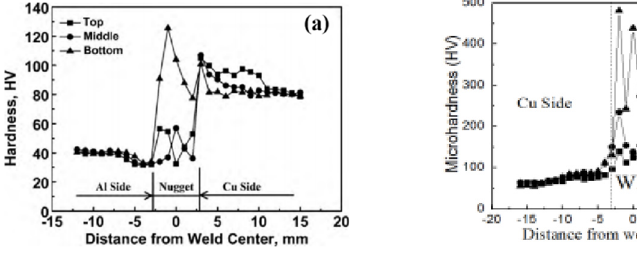
Figure 18. Microhardness profile: ( a ) from ref. [3]; ( b ) from ref. [84]; and ( c ) from ref. [16].